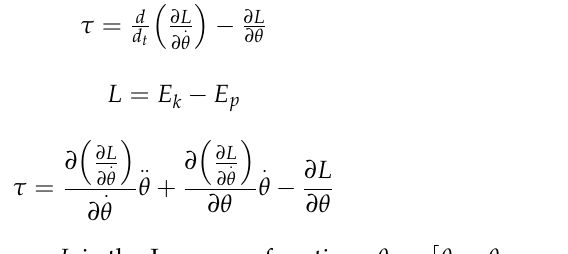
Figure 2. The schematic structure of a cable − driven planar hybrid robot with planar serial n − link with n degrees-of-freedom and m cables (If m < n , it’s an under-constrained cable-driven planar hybrid robot.).